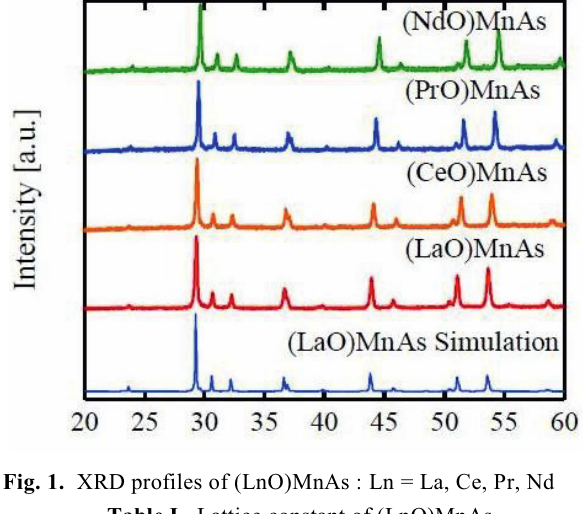
Table I. Lattice constant of (LnO)MnAs